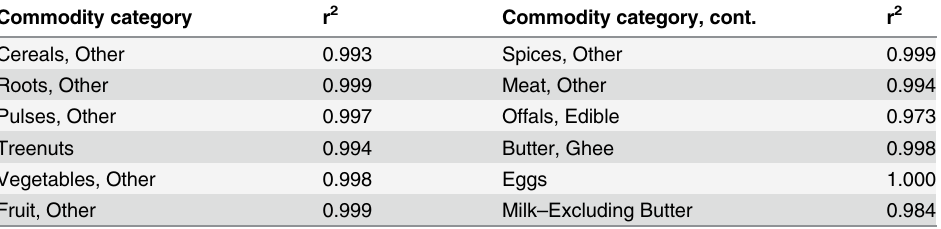
Table 1. GENuS-FBS Data Correlation. r-squared values relative to a 1:1 line between the GENuS model estimates and FBS domestic supplies. An example of their formulation is shown in Fig 1. Commodity category r 2 Commodity category, cont. Cereals, Other 0.993 Offals, Edible 0.973 Treenuts